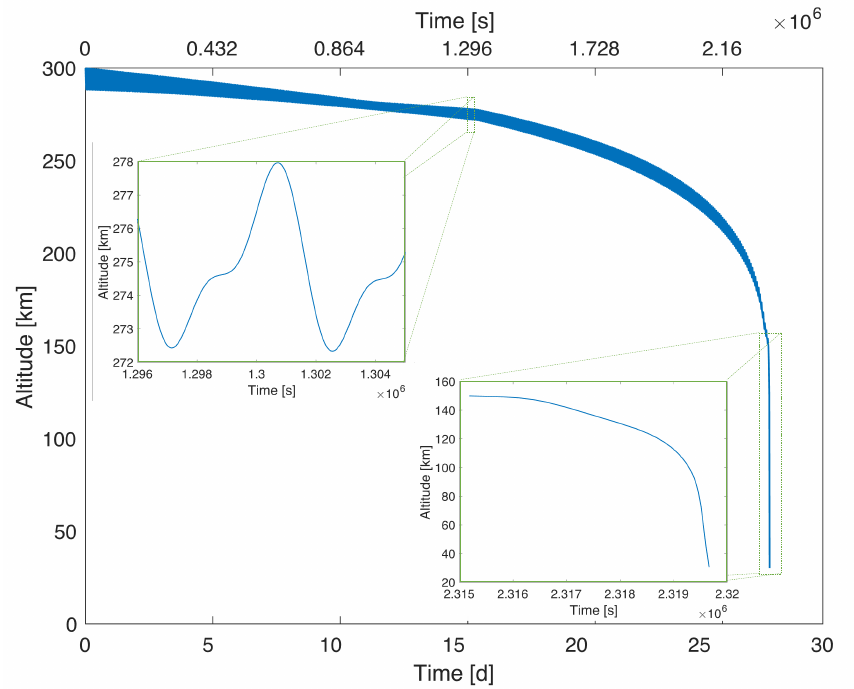
Figure 2. Reference trajectory provided by the path planner. The bottom axis displays the time scale in days, while the upper axis shows it in seconds. The main figure depicts the complete reference trajectory, from the de-orbit point up to the target altitude ( H = 30 km); the two minor figures present the details of the de-orbiting path (on the left) and atmospheric entry trajectory (on the right). In Figure 3, the heating flux on the capsule for the whole descent phase is shown.